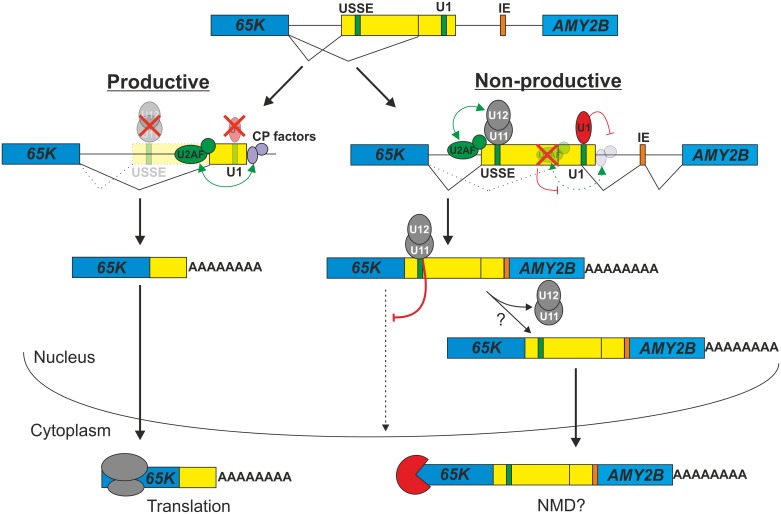
Model for 65K regulation: Alternative exon definition interactions in the 65K 3′UTR determine the choice between nuclear export and nuclear retention.Alternative splicing in the 65K gene generates either a short-3′UTR splicing isoform (productive) or a long-3′UTR splicing isoform (non-productive). For the long-3′UTR isoform, aberrant 3′-end processing together with bound U11 snRNP (or U11/U12 di-snRNP) as a retention factor provide a dual mechanism for nuclear retention. For the short-3′UTR isoform, optimal terminal exon definition interactions overcome U1-mediated inhibition of CP to ensure efficient nuclear export.